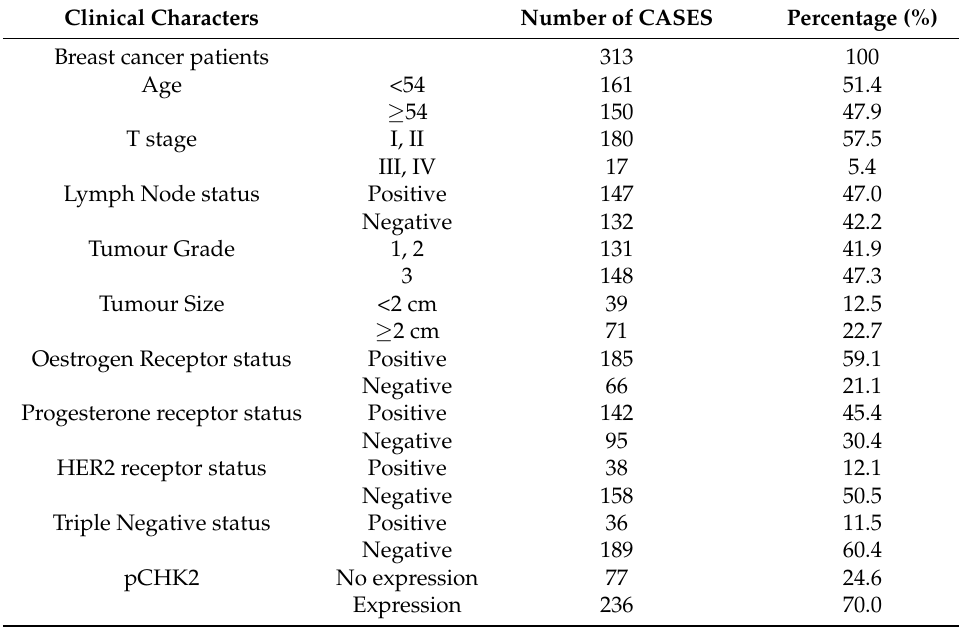
Table 2. Clinical characterisation of breast cancer